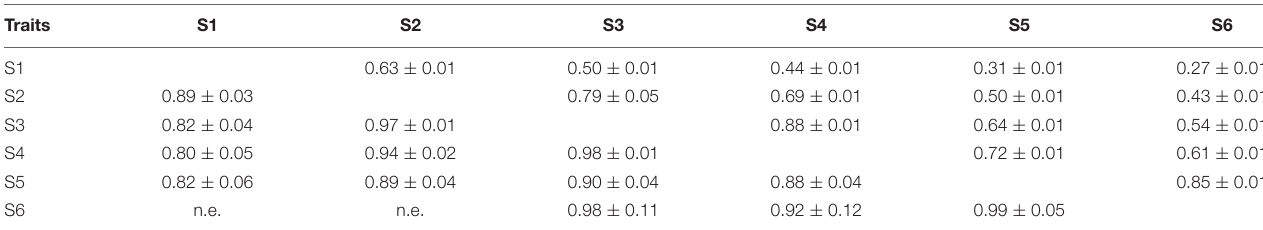
TABLE 4 | Phenotypic (above) and genetic (below the diagonal) correlation among survival traits. Traits S1